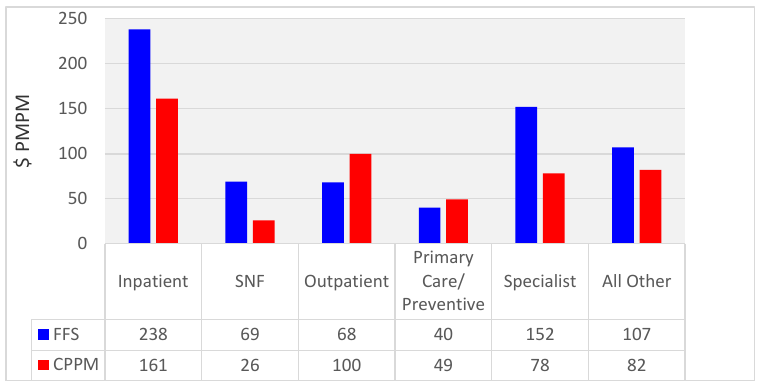
Figure 1. 2010 through 2014 Costs by Service Category ($PMPM). CPPM is the Collaborative Payer Provider Model. FFS is the 5% Limited Data Set from Fee-For-Service Medicare. PMPM is Per Member Per Month costs. SNF is Skilled Nursing Facility. PMPM costs were risk-adjusted to a 1.00 risk basis to make them comparable between FFS and CPPM.